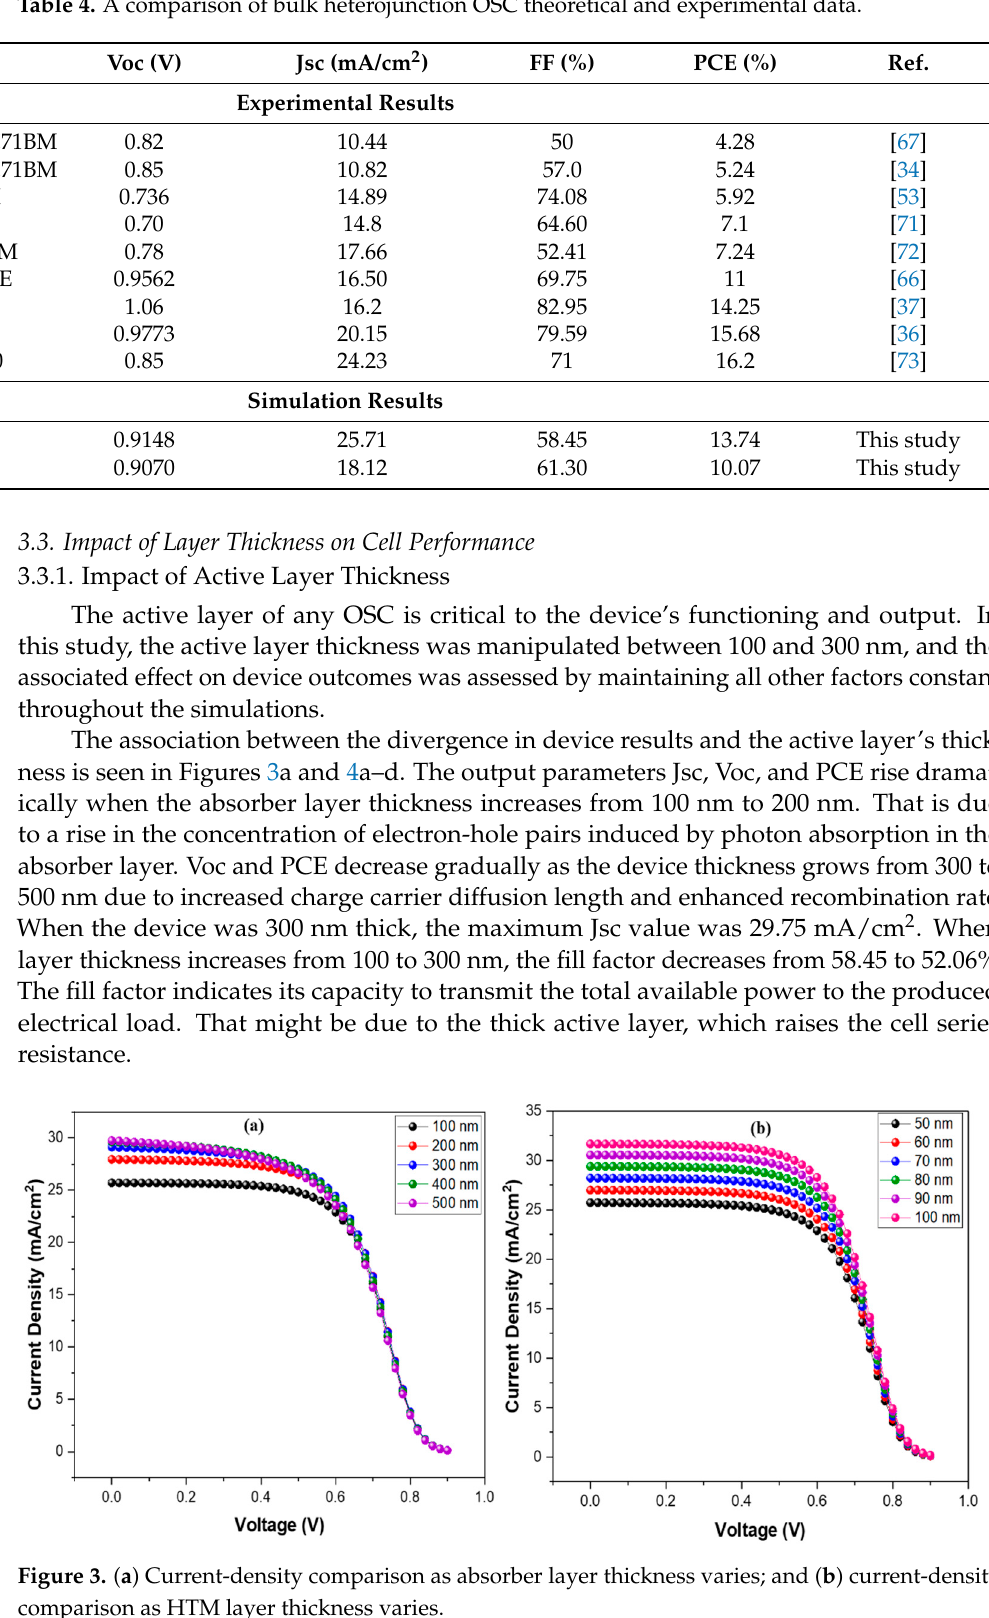
Figure 4. ( a , e ) Voc as a function of active layer and HTM layer thickness; ( b , f ) Jsc as a function of active layer and HTM layer thickness; ( c , g ) FF as a function of active layer and HTM layer thickness; and ( d , h ) PCE as a function of the active layer and HTM layer thickness. 3.3.2. Impact of HTM Layer Thickness The hole transport layer heavily influences the output of the OSC. A good selection of HTM allows for improved charge transmission and collection at the electrodes. This study utilizes graphene oxide as an HTL due to its potential optical and electrical proper- ties. Its thickness was changed from 50 nm to 100 nm to observe the effect on output pa- rameters. Jsc and PCE improved greatly when the thickness of the HTM layer was in- creased, owing to the superior charge transport properties of graphene oxide and better interaction with the absorber layer. The significant effect on output parameters can be visualized in Figure 4e–h, wherein negligible effects can be seen on Voc and FF. The opti- mized thickness value for HTM can be 100 nm [41], and this value of thickness is very advantageous for making photovoltaic cells more efficient. It also specifies a feasible way